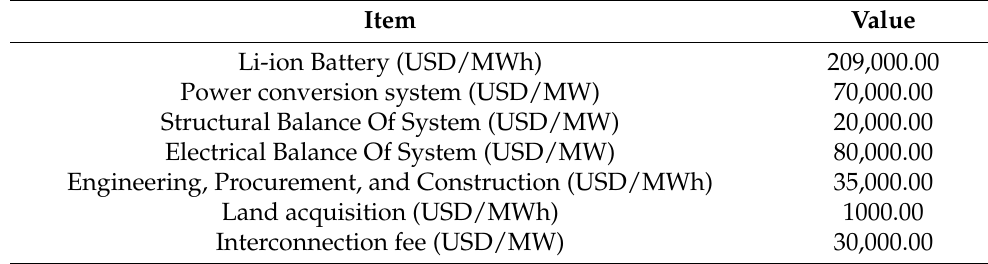
Table 2. Cost breakdown of ESS based on Li-ion